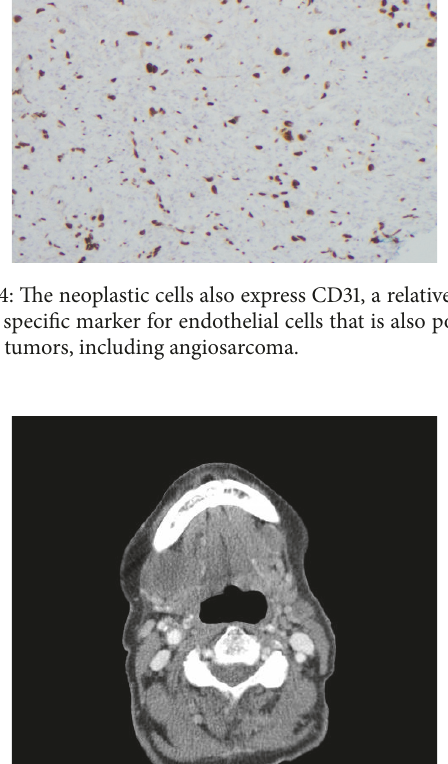
Figure2:Thecellsareuniformlypositiveforvimentin,anonspecific stain that confirms the mesenchymal origin of tumors.